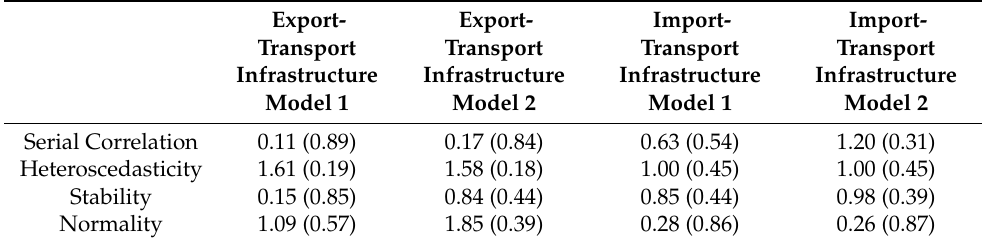
Table 7. Robustness of